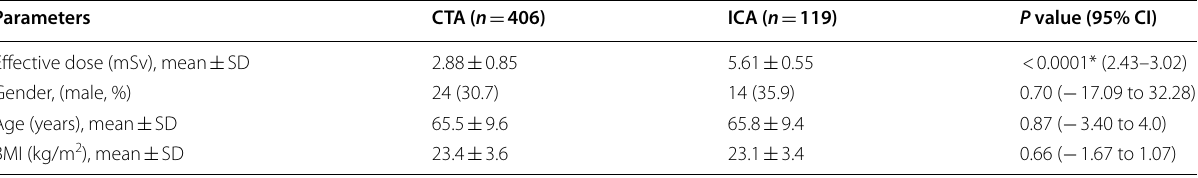
*Statistically significant at the p value <